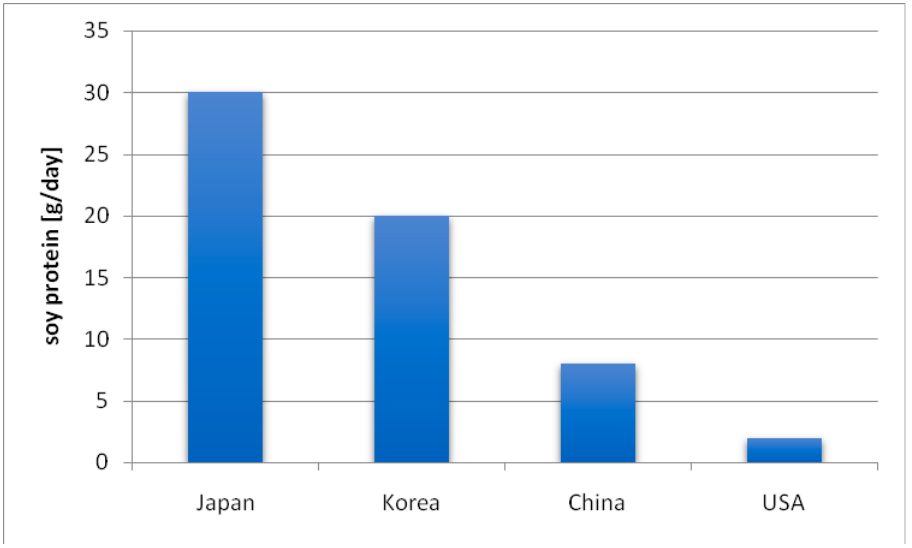
Figure 3. Soy consumption across different populations [20].